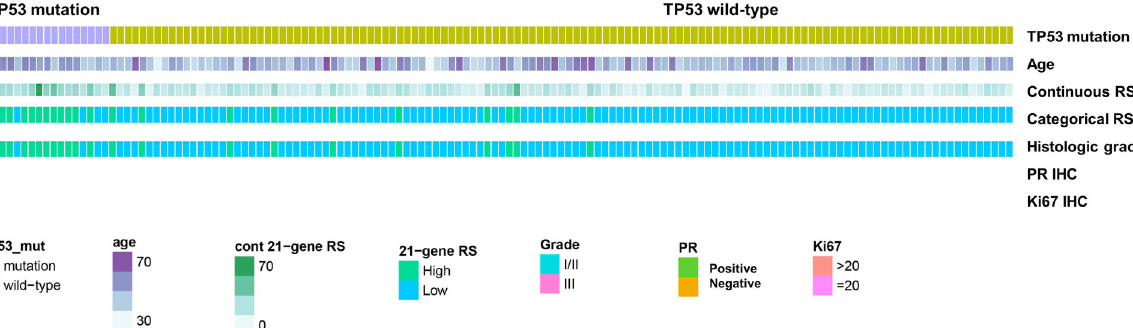
Fig. 3 Heatmap with 21-gene recurrence score and sequenced TP53 gene ( n = 141). Median age and 21-gene recurrence scores based on TP53 mutation compared using Mann – Whitney U tests. Distribution of Oncotype DX risk group compared according to mutated TP53 using χ 2 tests. Histological grade, progesterone receptor status, and Ki-67 expression were compared using Fisher ’ s exact tests.